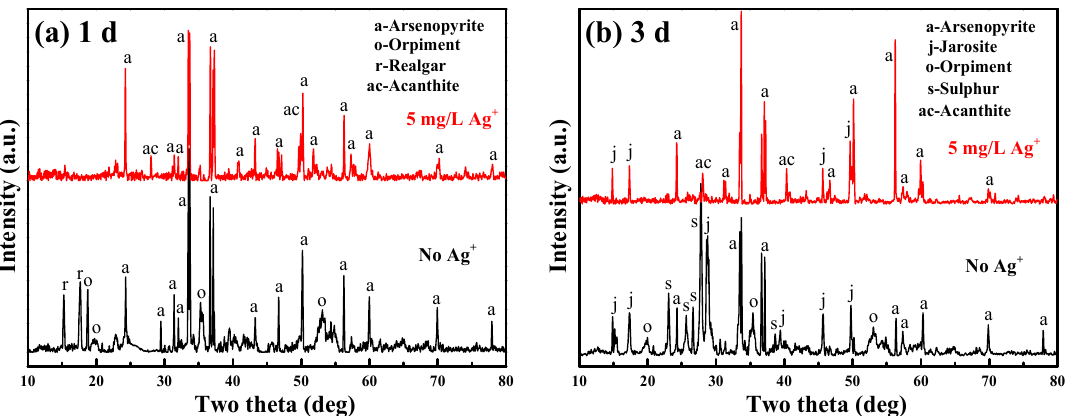
Figure 3. XRD diffractograms of the bioleached arsenopyrite particles after leaching ( a ) 1 day and ( b ) 3 days with and without 5 mg/L Ag + .